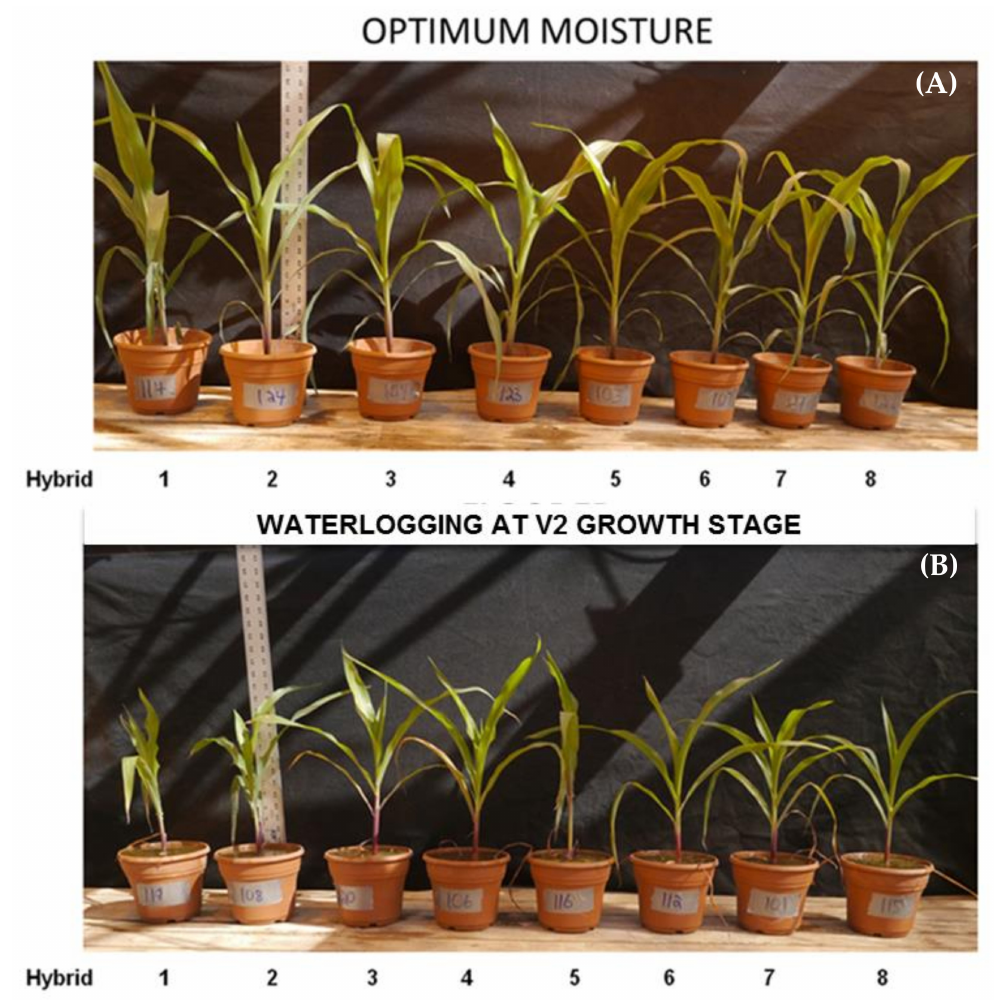
Figure 9. Visual differences in corn plant height and growth between nonwaterlogged ( A ) and waterlogged ( B )